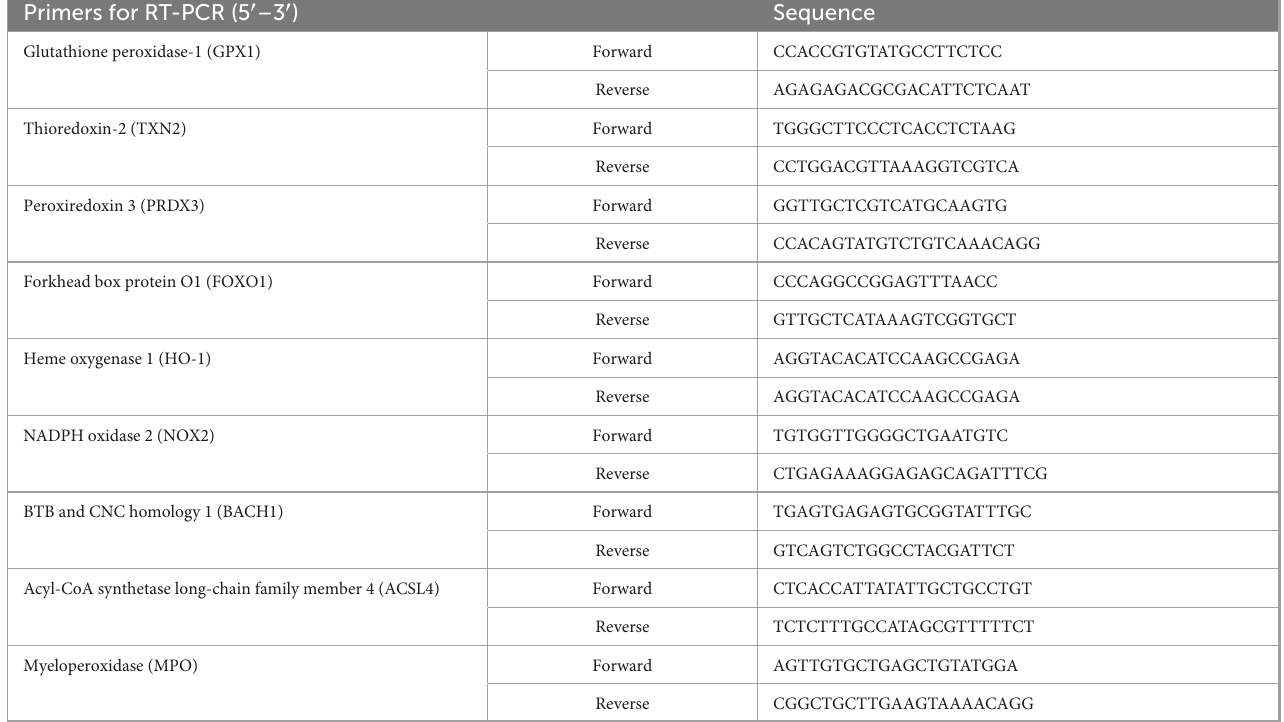
TABLE 3 Primer sequences for RT-PCR (mouse). Primers for RT-PCR (5 (cid:48) –3 (cid:48) )